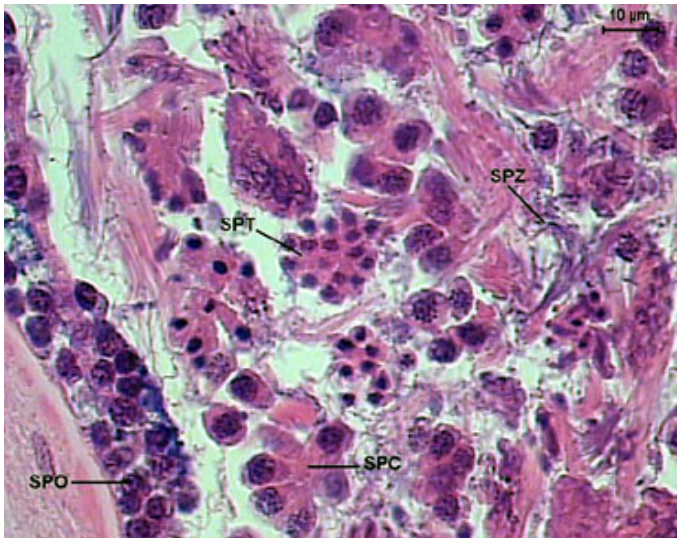
Figure 21. Detail of the Sticholecitha serpentis testicles. SPO – spermatogonia, SPC – spermatocytes, SPT – spermatids, SZP - spermatozoa.